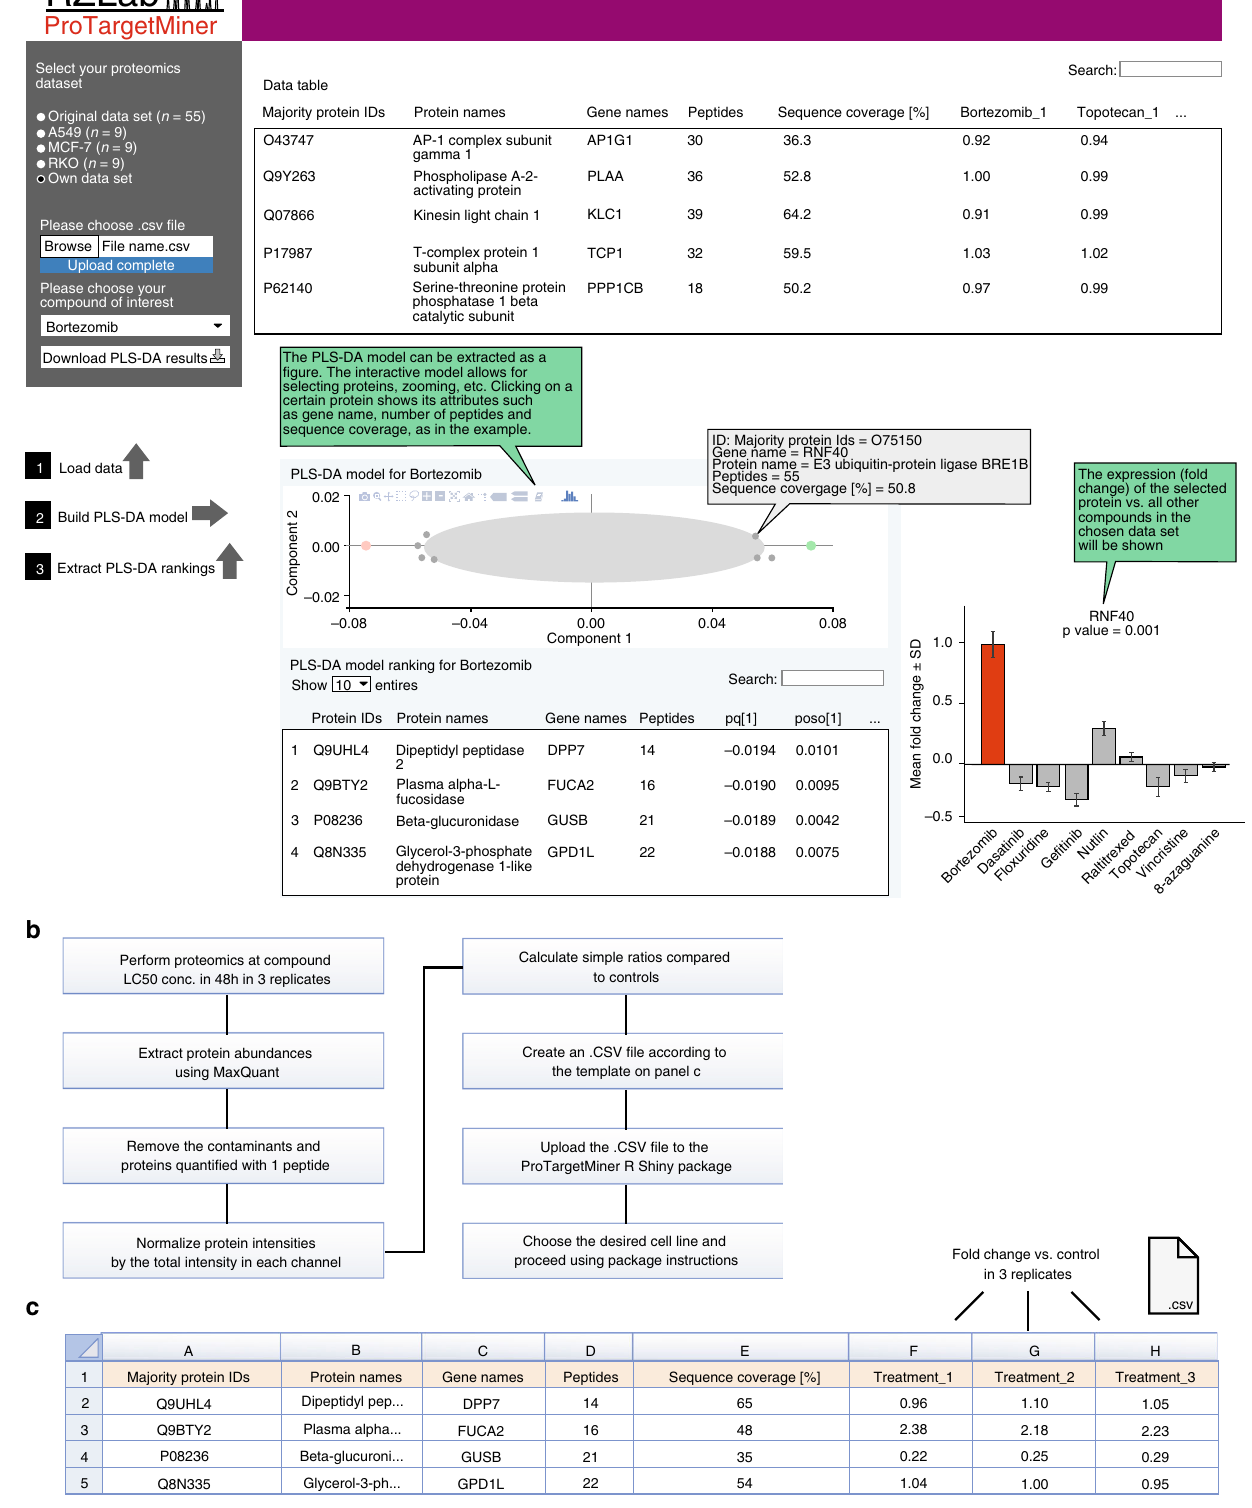
Fig. 7 The ProTargetMiner R Shiny package for deconvolution of drug target and MOA. a the ProTargetMiner R Shiny package interface. The input is the proteomics data for a desired compound and the output is the .CSV fi le containing the ranking of proteins for the compound against the desired panel in a PLS-DA model. Clicking on the interactive PLS-DA plot gives the attributes of the selected proteins, e.g. name, number of peptides, sequence coverage and signi fi cance compared to control, and will show the regulation of that protein in the compound panel. b step-by-step procedure of the use of ProTargetMiner R Shiny package. c the input .CSV template with the required